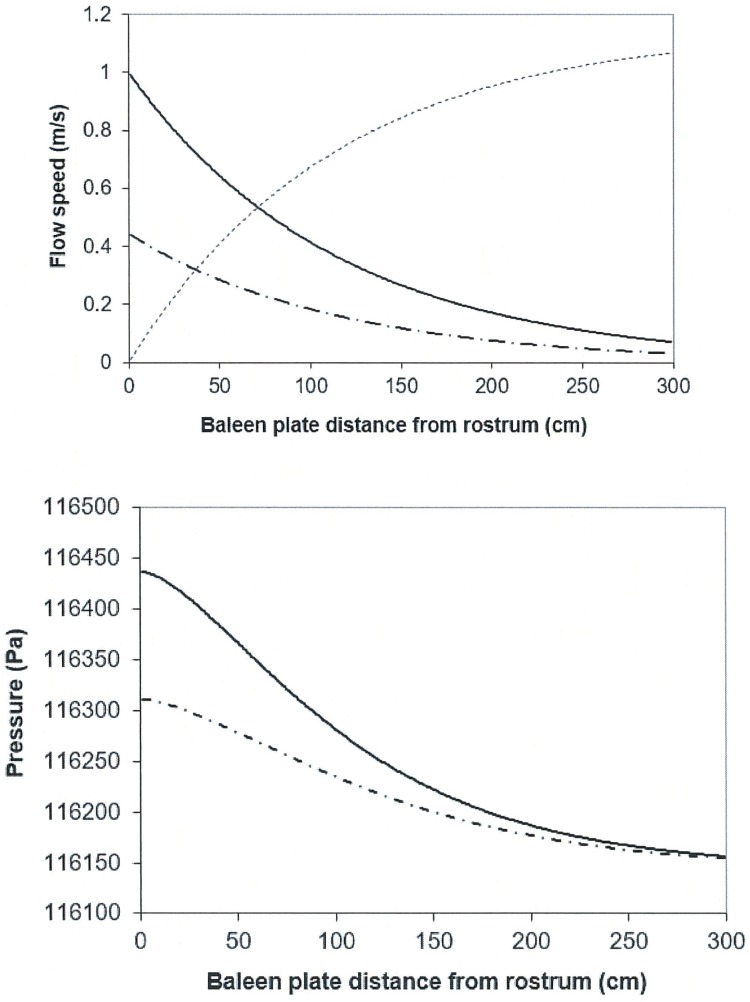
Calculated flow speeds and pressure drops for a 10m-whale swimming at Uwhale = 1.0m/s.The IB, APT and APL flow speeds correspond to the dash-dot, continuous and dashed lines respectively; and the pressure profiles in the APT and APL canals likewise corresponding to the continuous and dash-dot lines. The inputs used in both frames are: 10m body length, dbaleen = 0.01m, cbaleen = 0.07m, hHT = 1.5m and Din = 0.5m, WPO = 0.435m, a = 0.071 and C = 0.44 (“with prey” [9]). Further input details are listed in Tables 1 and 2.